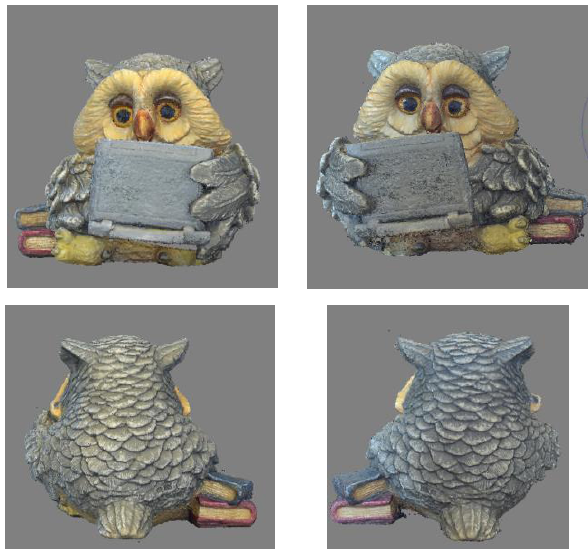
Figure 6: 3D point cloud of both parts of the real object (left) and of its reflection (right)